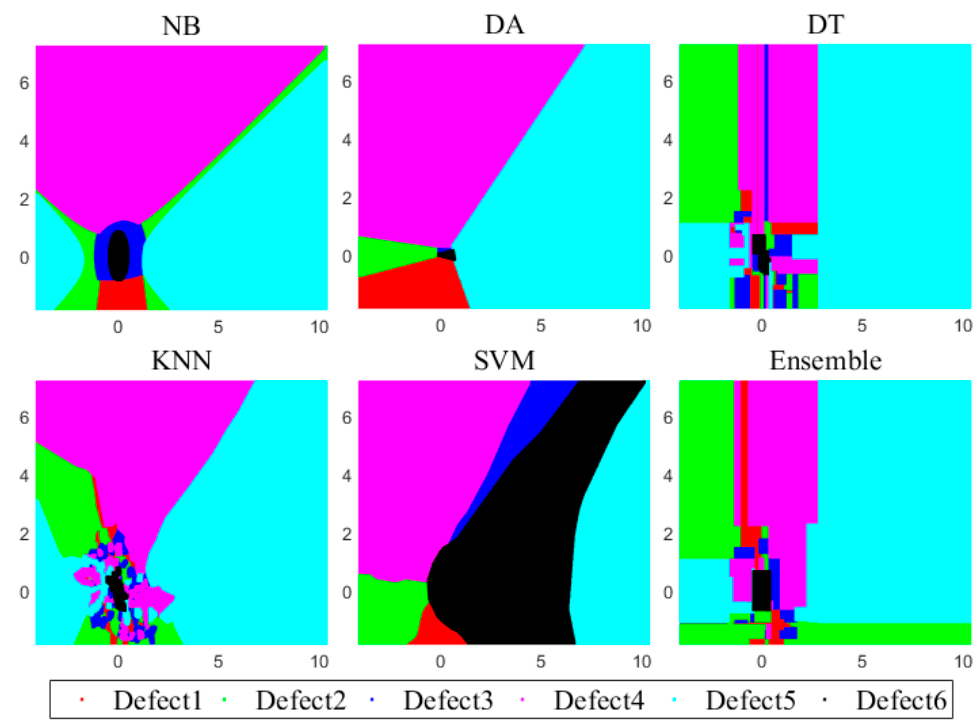
Figure 12. Decision surface by different classifiers.